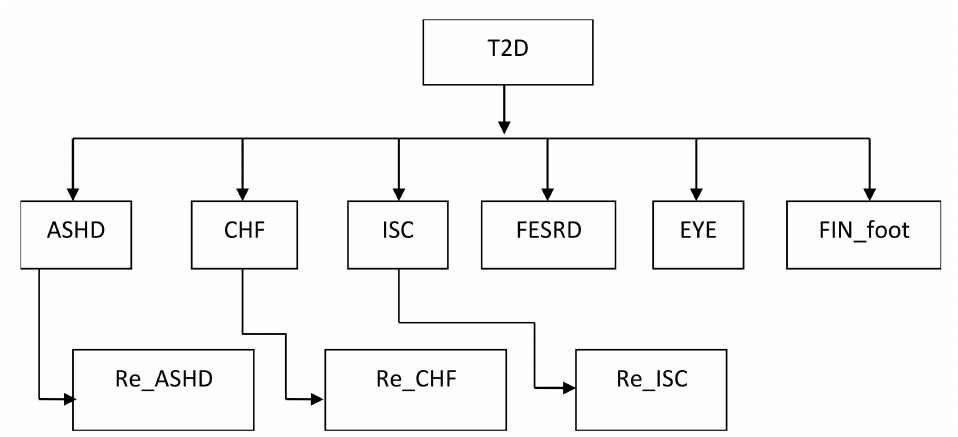
Figure 1. Logic structure of a prediction model. Abbreviation: T2D, type 2 diabetes; ASHD, arte- riosclerotic heart disease; CHF, chronic heart failure; EYE, retinopathy; FESRD, first-time renal failure; FIN_FOOT, amputation; ISC, ischemic